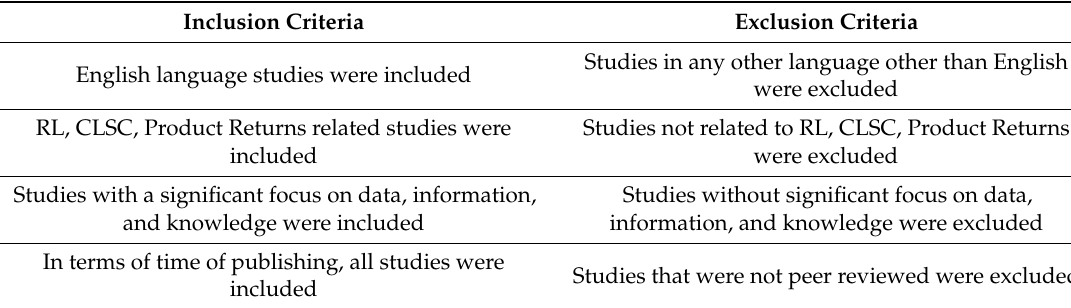
Table 2. Inclusion and exclusion